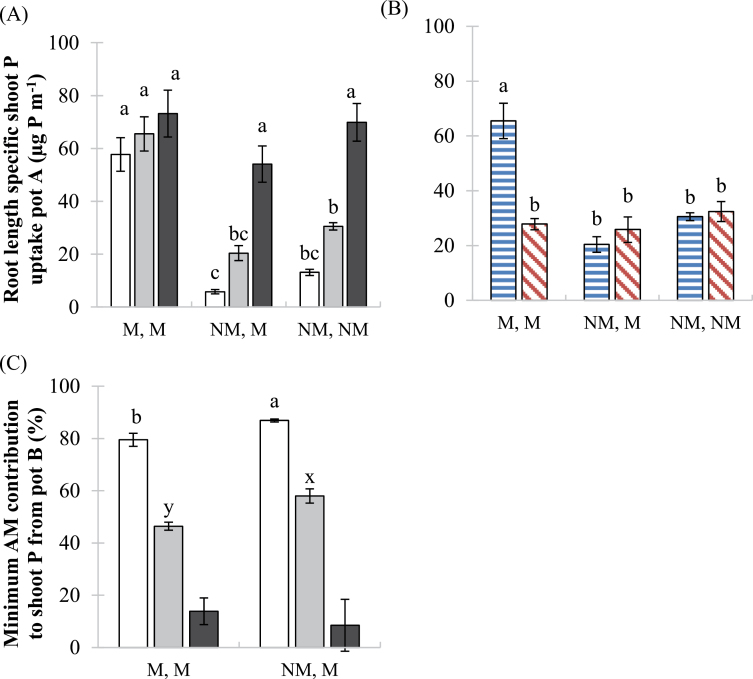
Pi uptake via the direct Pi uptake pathway and the mycorrhizal pathway. (A) Root length-specific shoot Pi uptake from pot A and (C) the minimum contribution by AM fungi from pot B to shoot P of wild-type plants at three soil P additions: 0 (white bars), 20 (grey bars), and 50 (black bars) mg P kg–1. (B) Root length-specific shoot Pi uptake from pot A in the wild type (horizontal bars) and mtpt4 mutant (diagonal bars) at P20 only. Values are mean ±standard error, n=5. Means followed by the same letter were not significantly different at the P<0.05 level (Tukey’s HSD). For (A) data were analysed in more detail at each P level by a Student’s t-test comparing the treatment pots (NM of NM,M) and the NM control (NM,NM), which revealed significantly reduced P uptake from pot A in NM,M plants grown at P0 and P20. For (C) different sets of letters (ab, xy) indicate a significant difference (at the P<0.05 level, Student’s t-test) between M,M and NM,M pots. (This figure is available in colour at JXB online.)